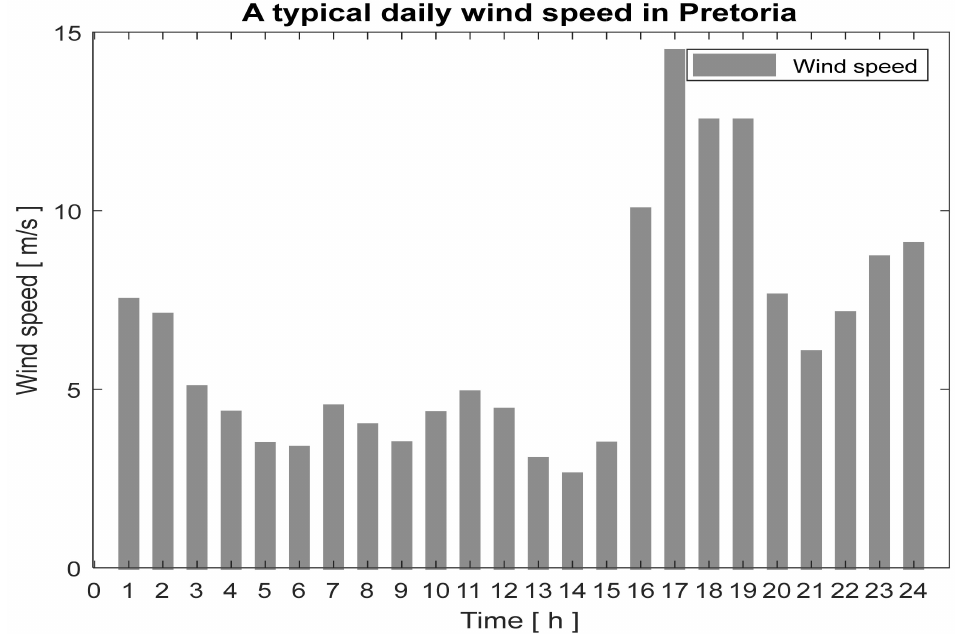
Figure 5. A typical 24 h daily wind speed in